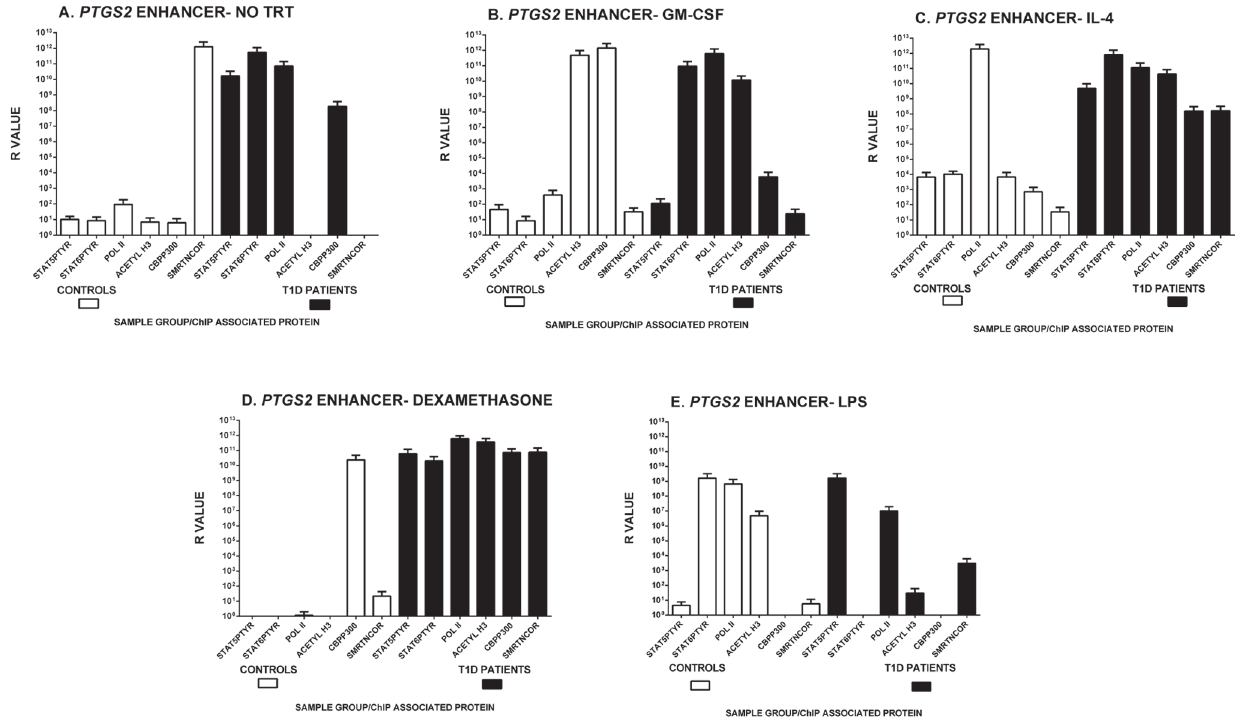
Figure 5. Multiplex ChIP analysis of Protein Binding, Epigenetic Modification, and Transcription at the PTGS2 enhancer region. Peripheral blood PBMC monocytes were isolated and incubated at 37 u C/5%CO 2 for 2 hr in the continuous presence of (A) media alone (0) or media supplemented with (B) 5.6 nM GM-CSF (GM-CSF), (C) 500 U/ml IL-4 (IL4), (D) 100 m M dexamethasone (DEX), or (E) 1 ng/ml endotoxin (LPS). This timeframe is used to allow for optimization of the negative (DEX) and positive (LPS) control stimulation. The cells were washed and extracted for